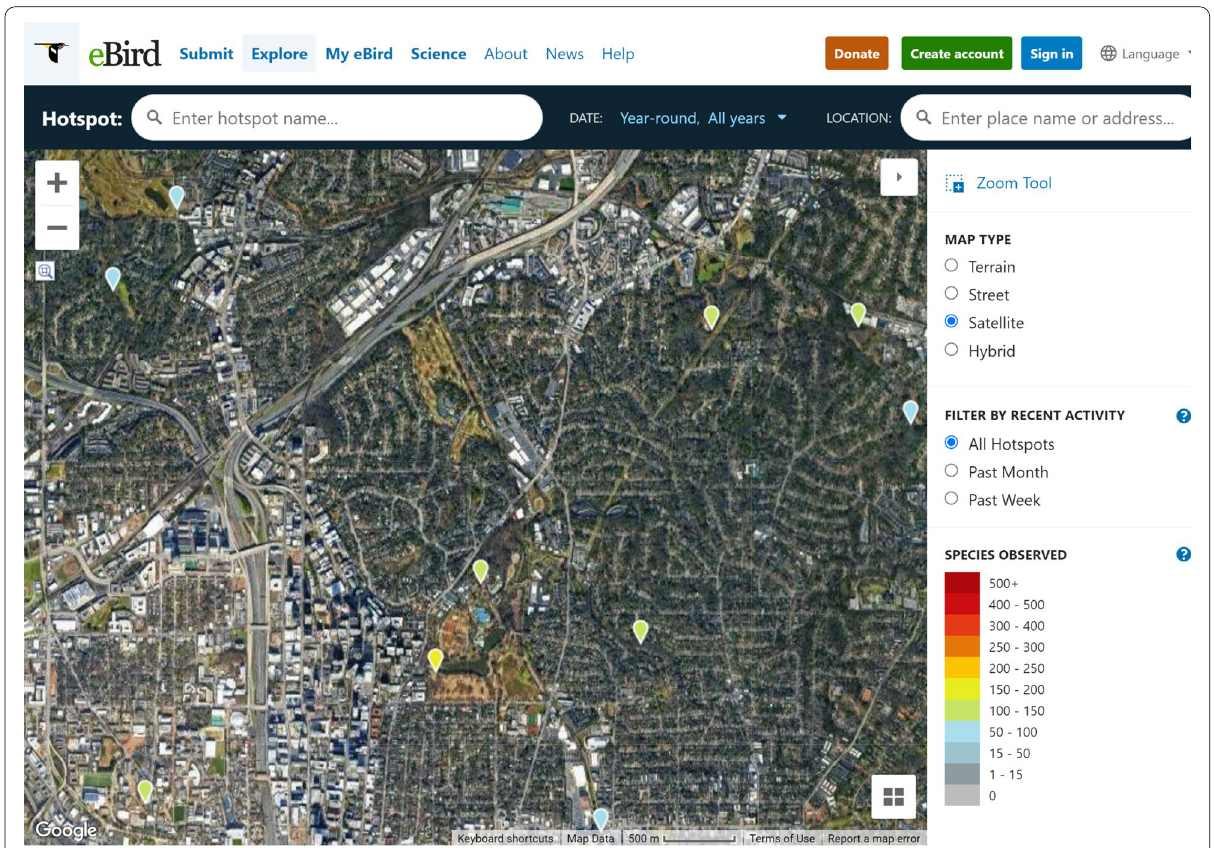
Fig. 1 A screenshot from ebird.org in Piedmont Park, Atlanta, Georgia, U.S.A., Although birders detect birds throughout the park, there are only two options to geolocate their findings (one at the park information desk, and one at the botanical gardens information desk). This could lead users to believe that birds are concentrated in those two